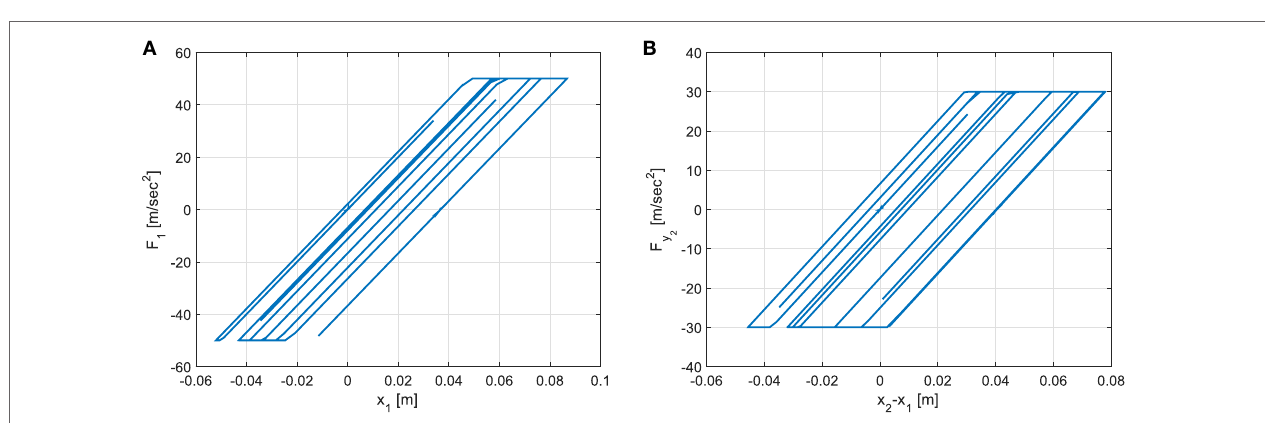
= 30 [m/s 2 ] is subjected to the excitation of Figure 11A . The F y 1 occurring displacements of both masses are measured as shown in Figure 11B